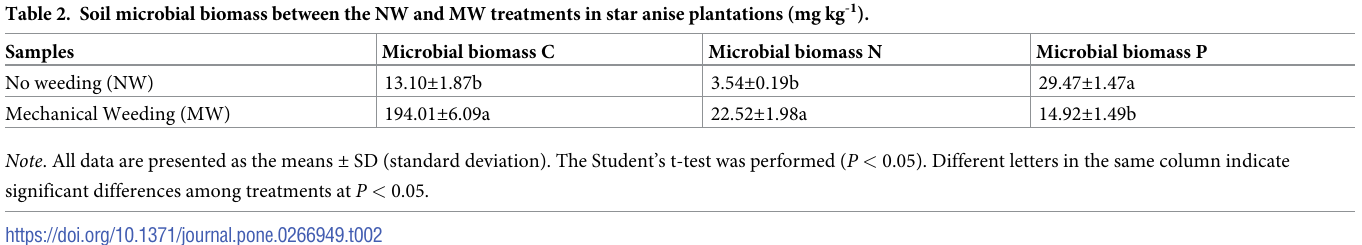
Note . All data are presented as the means ± SD (standard deviation). The Student’s t-test was performed ( P < 0.05). Different letters in the same column indicate significant differences among treatments at P < 0.05.